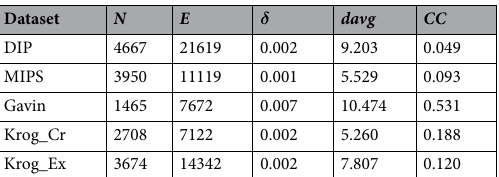
Table 1. The topological parameters of the PPI datasets. N is the number of nodes, E is the total edge count, δ , d avg is average degree and CC is the clustering coefficient. Krog_Cr and the network density defined as ( ) E N / 2 Krog_Ex are the Krogan Core and Krogan Extended data sets respectively.